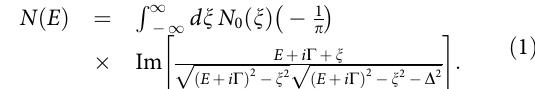
ph i ffiffiffiffiffiffiffiffiffiffiffiffiffiffiffi x 2 þ D 2